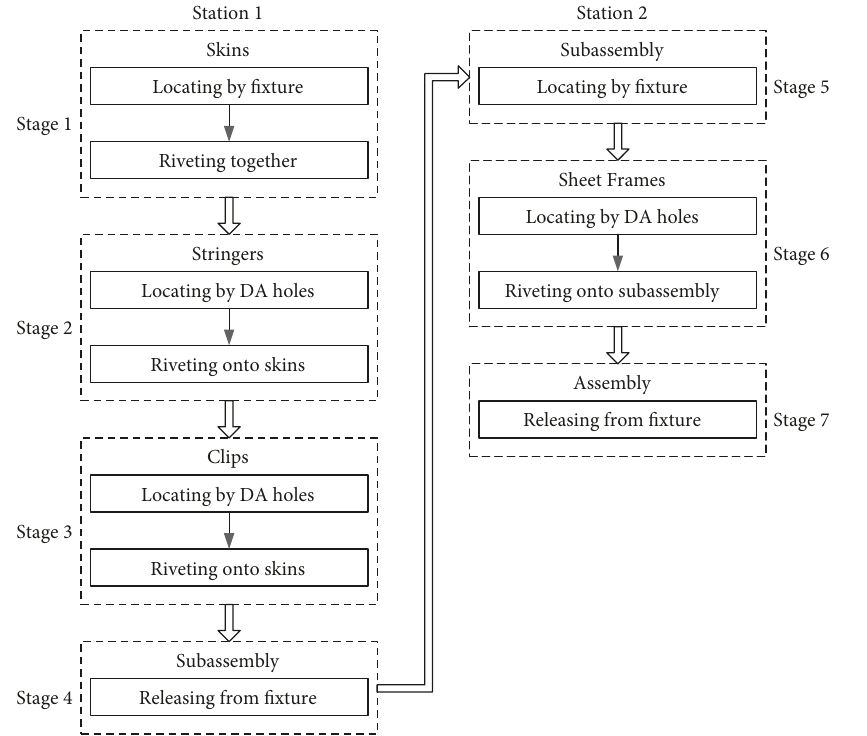
Figure 4: The entire assembly process of an aircraft panel.